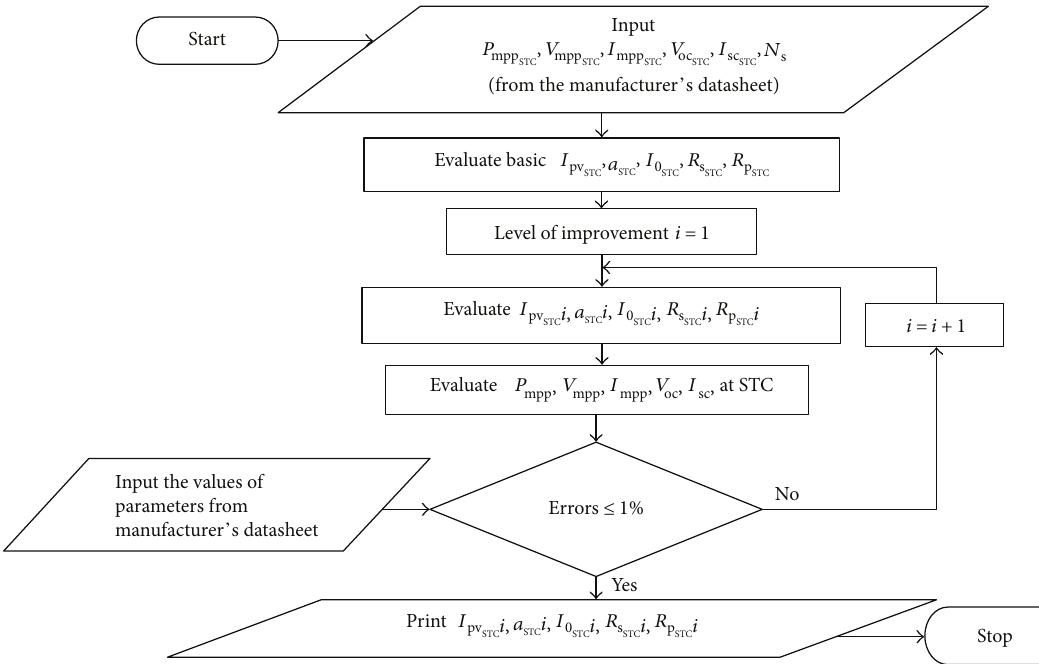
Figure 2: Flowchart for evaluation of fi ve unknown parameters ( I